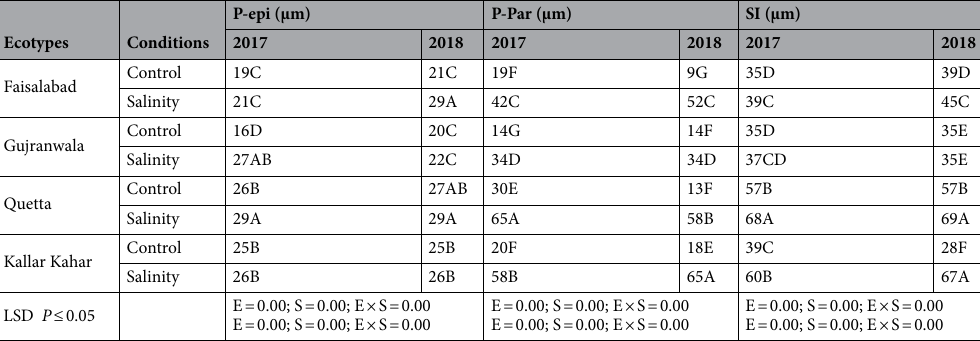
LSD P ≤ Table 3. Depiction of mean values of pericarp epidermis (P-epi), pericarp parenchymal cell layer (P-Par) and seed integument epidermis (SI) as influenced under control and salinity stress during 2017 and 2018. Different letters within the same column indicate statistically significant differences, critical value for comparison (CVC). CVCP-epi 2017: E = 1.88; S = 1.32; E × S = 2.65: CVCP-epi 2018: E = 1.67; S = 1.18; E × S = 2.37. CVCP- Par 2017: E = 2.57; S = 1.82; E × S = 3.64: CVCP-Par 2018: E = 2.28; S = 1.61; E × S = 3.23. CVCSI 2017: E = 2.22; S = 1.57; E × S = 3.14: CVCSI 2018: E = 2.66; S = 1.88; E × S = 3.76.